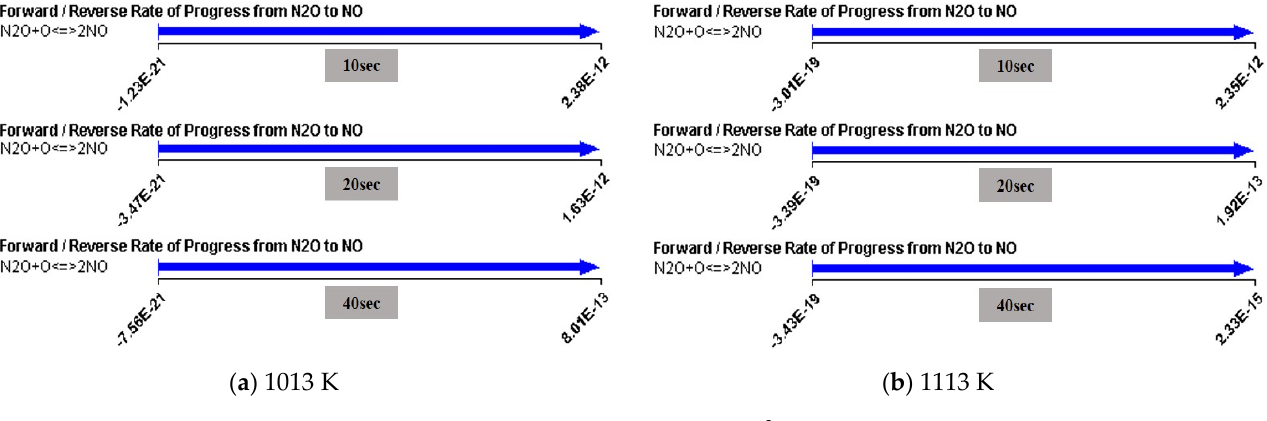
3 s) at 1013 and 1113 K. 2 O to N 2 (M/cm